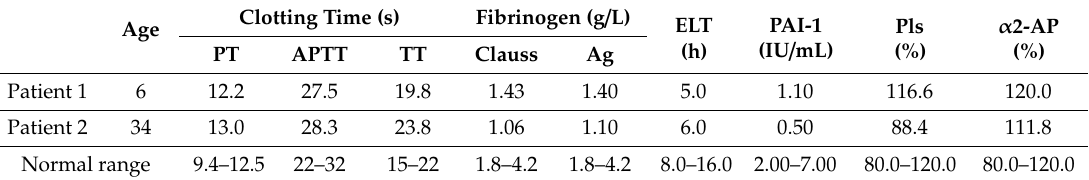
Table 1. Screening and special coagulation tests of two patients with